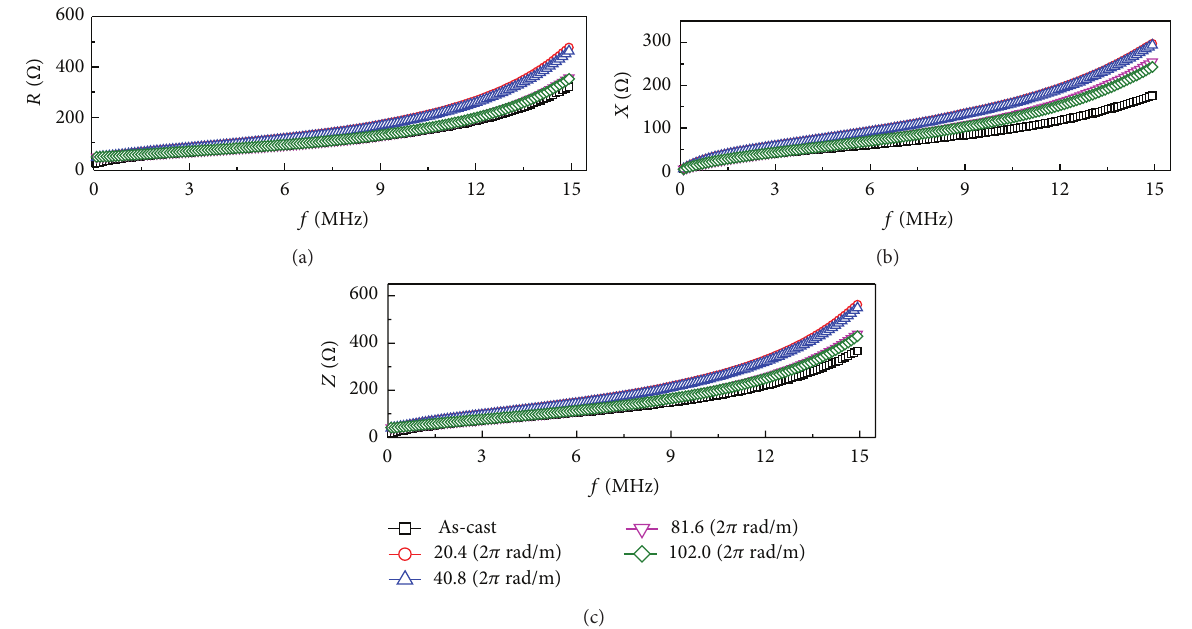
Figure 1: Frequency dependence of (a) resistance, (b) inductive reactance, and (c) impedance of microwires with different torsion stresses.